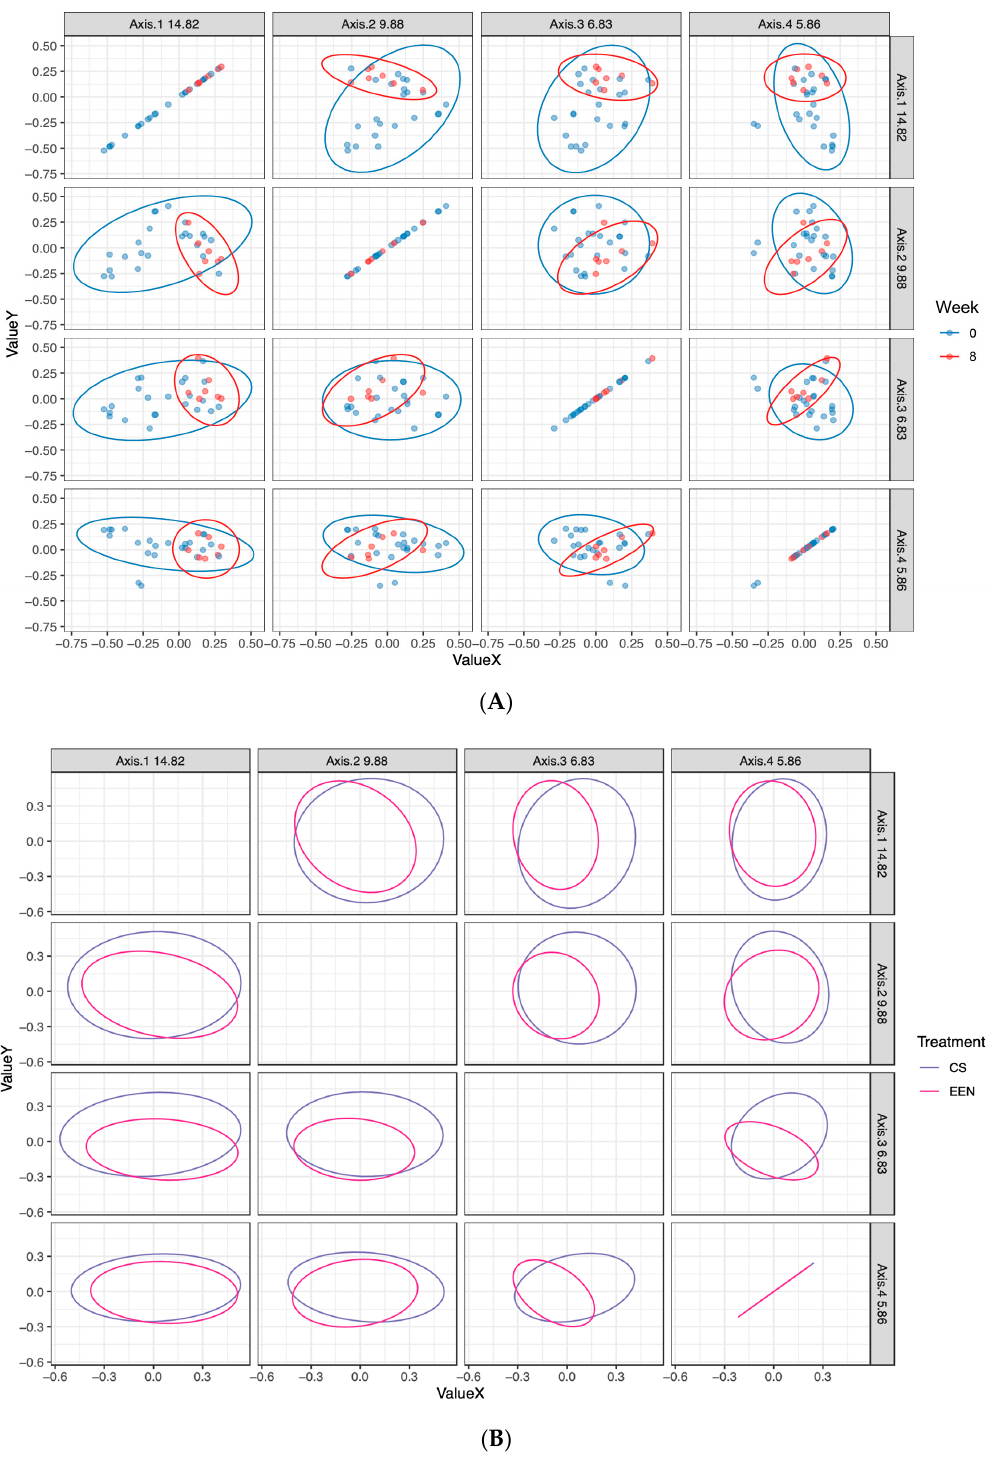
Figure 5. ( A ) Principal coordinate analysis of fecal microbiota at baseline (active disease) and end of treatment. Greater clustering was observed at the end of treatment independent of the disease type or treatment. ( B ) Principal coordinate analysis of the fecal microbiota in terms of the treatment type at the end of treatment. Principal coordinate analysis of patients at the end of treatment (week 8) in terms of the CS or EEN treatment type. Clustering was observed between all samples, independent of the treatment type. CS—corticosteroids, EEN—exclusive enteral nutrition.